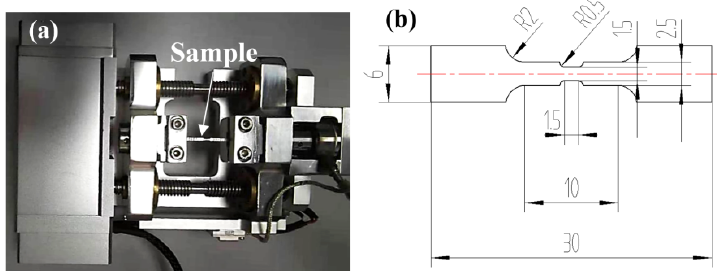
Figure 2. ( a ) Mechanical test bench; ( b ) geometry and dimensions of in situ tensile test specimens at room temperature (units: mm).